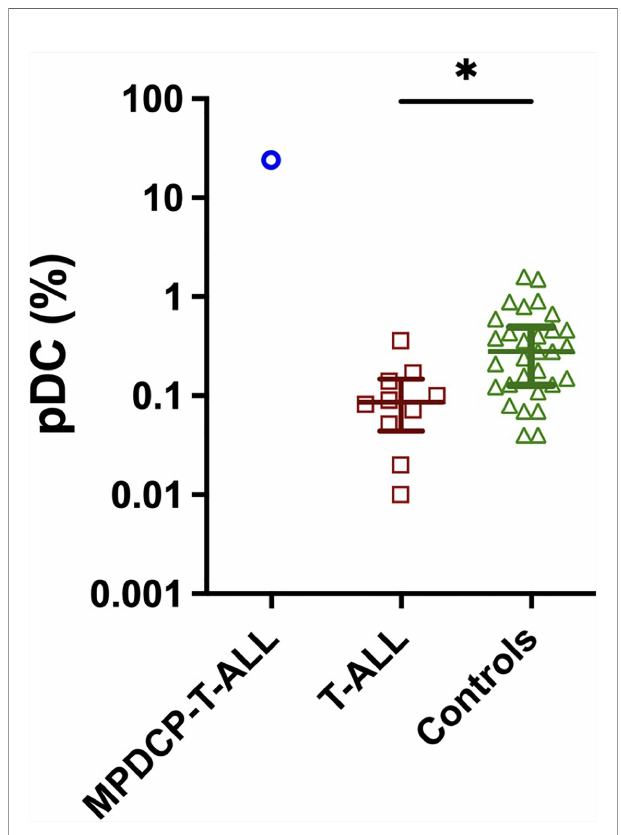
FIGURE 2 | Decreased pDC are frequent in patients with T-ALL. pDC frequency (percentage of white blood cells) in bone marrow aspirates from our index case of MPDCP-T-ALL, and from patients with T-ALL (n = 10) and controls (n = 30). Presents are median ± interquartile range. *p < 0.05 based on unpaired